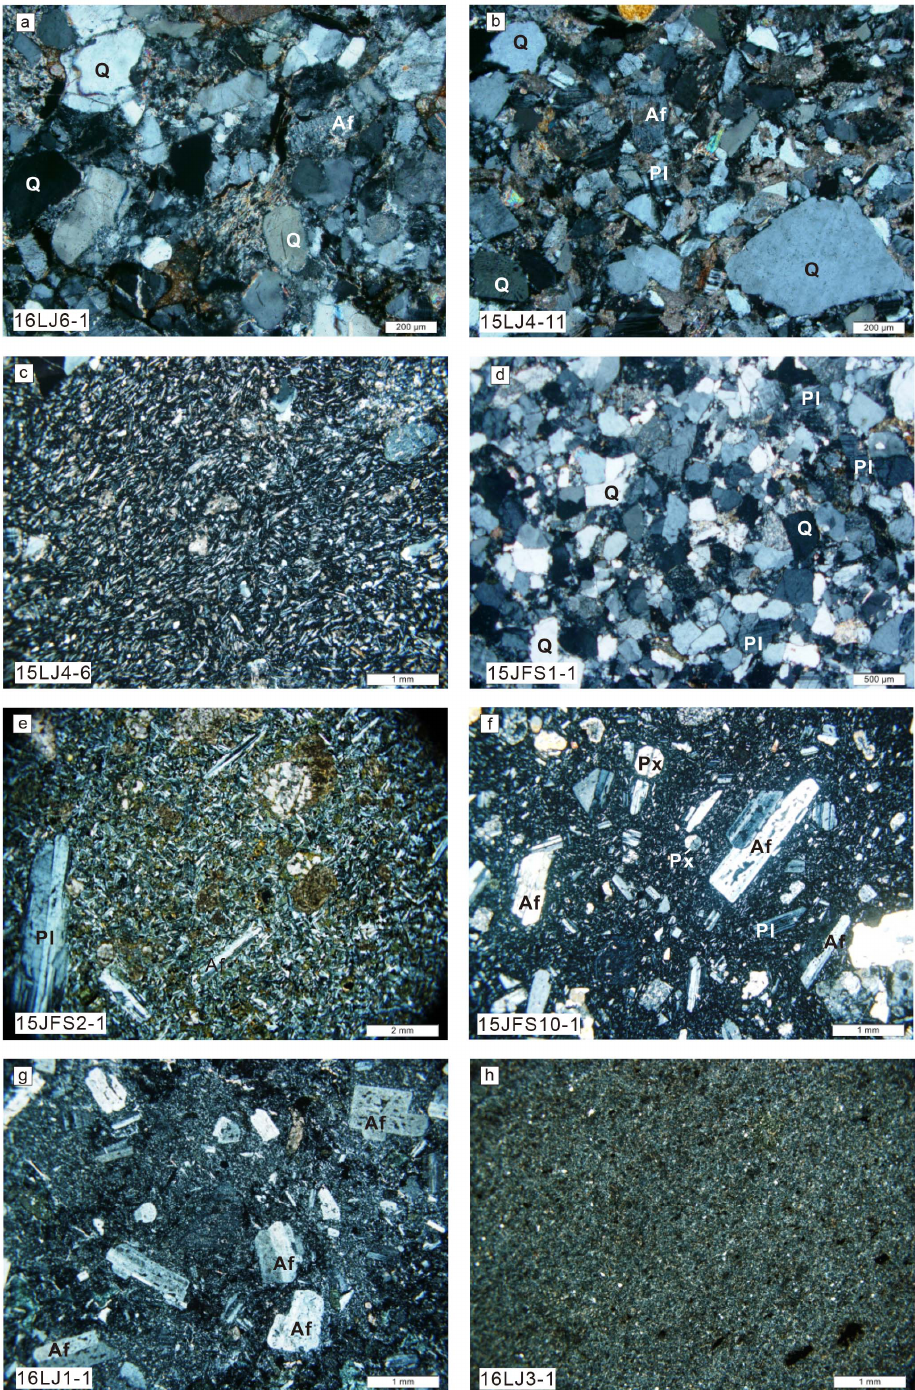
Figure 7. Photomicrographs of representative early Mesozoic samples (cross-polarized light). (a) Sample 16LJ6-1, a medium-grained felds- pathic quartz sandstone of the Heisonggou Fm; (b) sample 15LJ4-11, a fine-grained feldspathic quartz sandstone of the Heisonggou Fm; (c) sample 15LJ4-6, an andesite that intrudes into the Heisonggou Fm; (d) sample 15JFS1-1, a medium-grained feldspathic quartz sandstone of the Xiaoyingzi Fm; (e) sample 15JFS2-1, a diabase porphyrite that intrudes into the Xiaoyingzi Fm; (f) sample 15JFS10-1, a pyroxene andesite of the Guosong Fm; (g) sample 16LJ1-1, an andesite of the Changbai Fm; (h) sample 16LJ3-1, a tuffaceous siltstone of the Yihe Fm. Af: alkali feldspar; Pl: plagioclase; Px: pyroxene; Q: quartz.